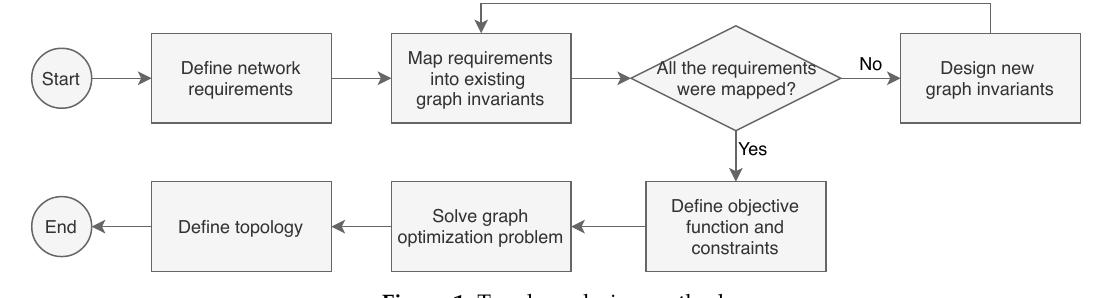
Figure 1. Topology design method.